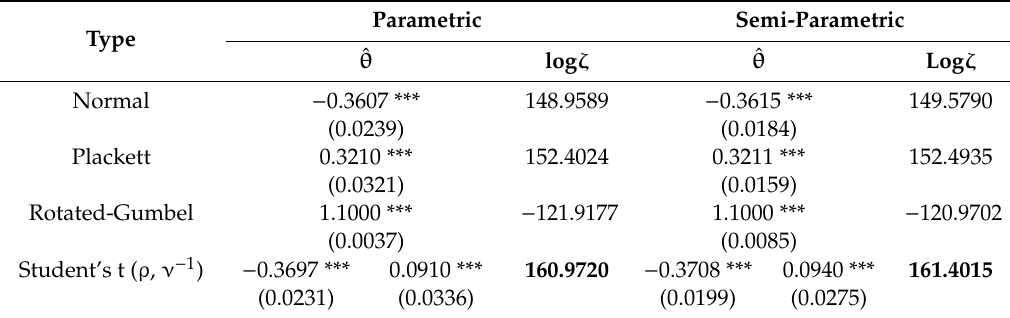
Table 7. Constant copula parameter estimation (Russian